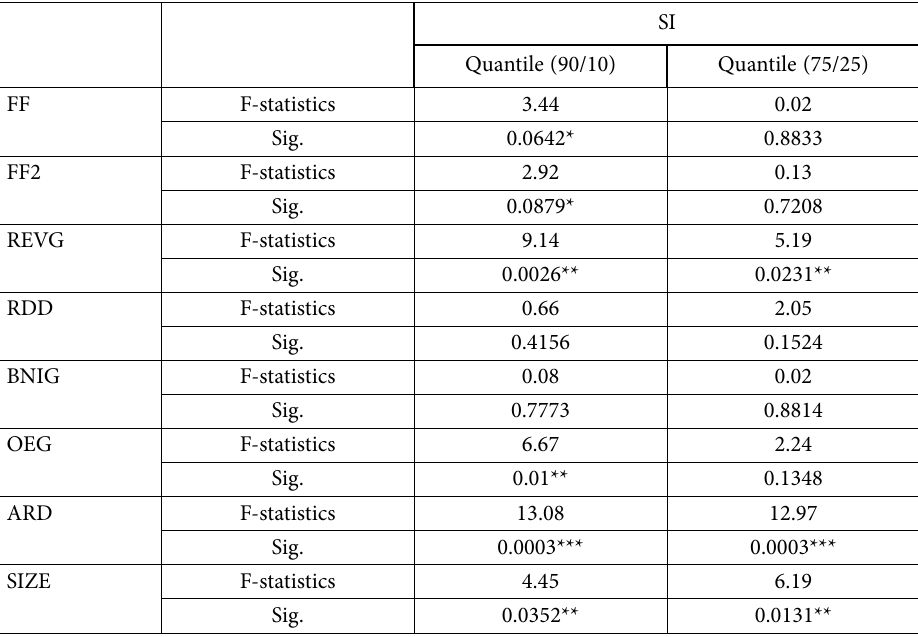
Table 5. Inter-quantile regression results for